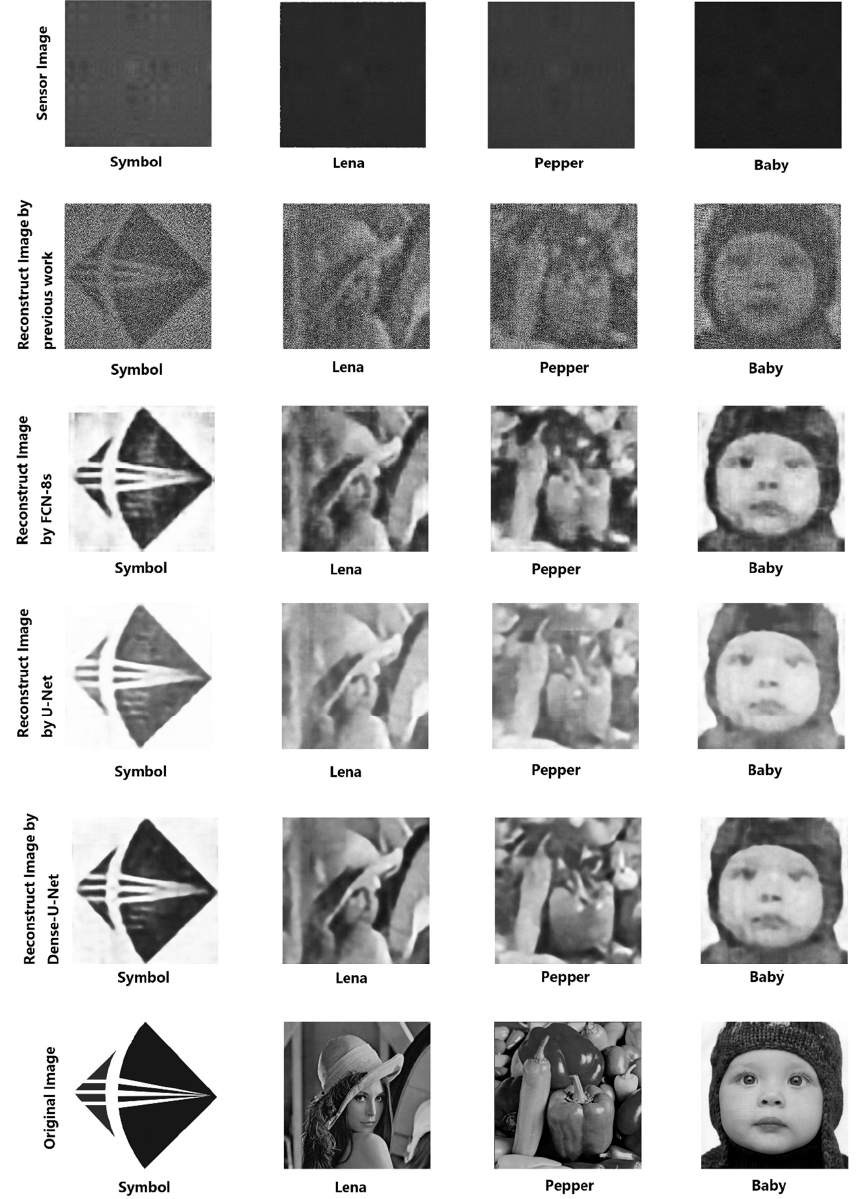
Figure 6. The figure above shows images captured by the sensor, the output results of different methods, and the original scene images. It can be seen that in terms of visual effect, the images processed by FCN-8s network are rough and the details are not recovered accurately, while the grayscale value of the images processed by U-Net network is not very accurate, and the image details and grayscale value processed by Dense-U-Net are relatively accurate.